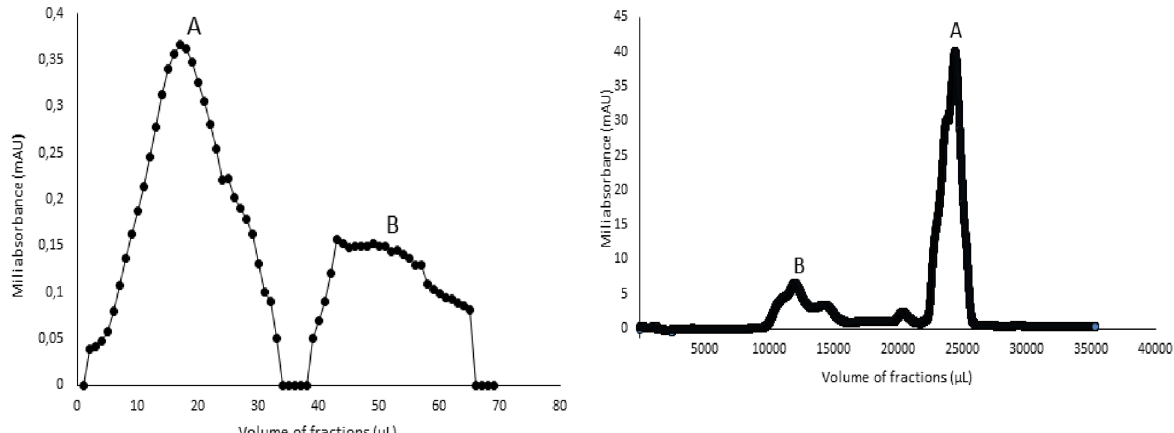
Figure 1. Gel-filtration chromatography with Superdex 75 HR 10/300. The main fractions with fibrinolytic activity collected after ion exchange chromatography were subjected to gel-filtration chromatography equilibrated with Tris-HCl/KCl 0.5 M buffer as the eluent. The fractions were collected for absorbance at 280nm. a- Peak containing the purified enzyme with fibrinolytic activity; b - Peak containing protein without fibrinolytic activity; c - Peak containing pigment extract without fibrinolytic activity.